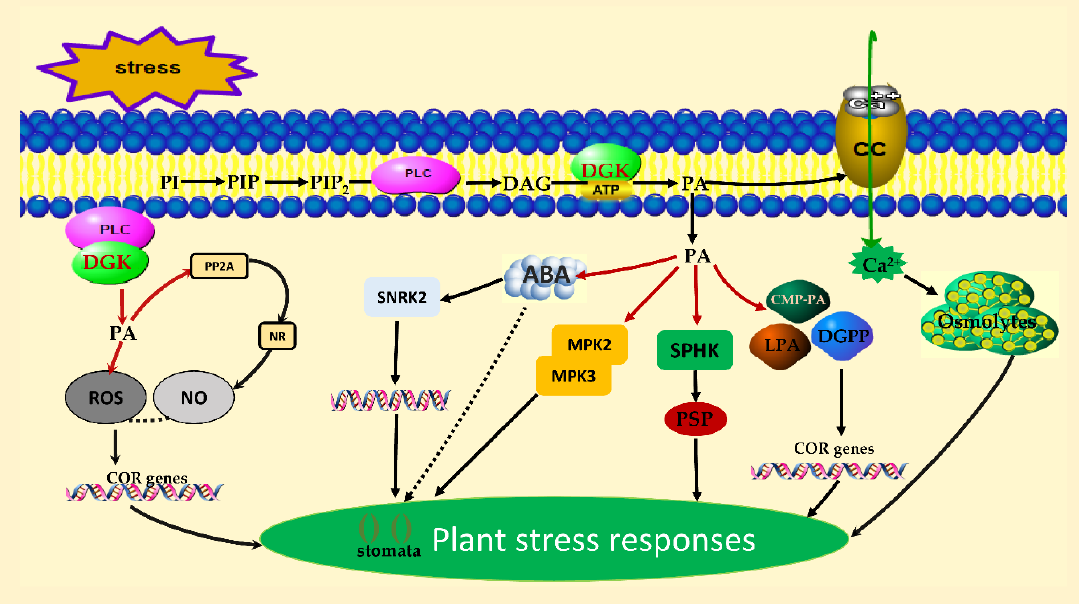
Figure 4. Role of DGKs in different pathways involved in the mechanisms of plant stress responses. The membrane-bound phospholipases are stimulated by the external stress and generated lipid signaling molecules in response to the stress. In this response mechanism, DGK (diacylglycerol kinase) promotes a chain of reactions that includes DAG (diacylglycerol) IP3 (inositol trisphosphate), PA (phosphatidic acid), MPK (mitogen-activated-protein kinase), the production of nitric oxide (NO), the Atypical Protein Phosphatase 2A (PP2A), and reactive oxygen species (ROS) in the cold stress response. PLC (phospholipase C), PLD (phospholipase D), SPHK (sphingolipid kinase), and SNRK2 (serine/threonine kinases) generate, and phytosphingosine phosphate (PSP) influences the ABA-dependent regulation of the plant abiotic stress responses. Finally, cytidine monophosphate-phosphatidic acid (CMP-PA), lysophosphatidic acid (LPA) and diacylglycerol pyrophosphate (DGPP). can also stimulate many cold-responsive (COR) genes.